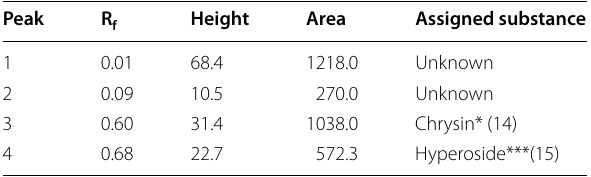
Table 12 Peak table of BPSAQ in mobile phase I